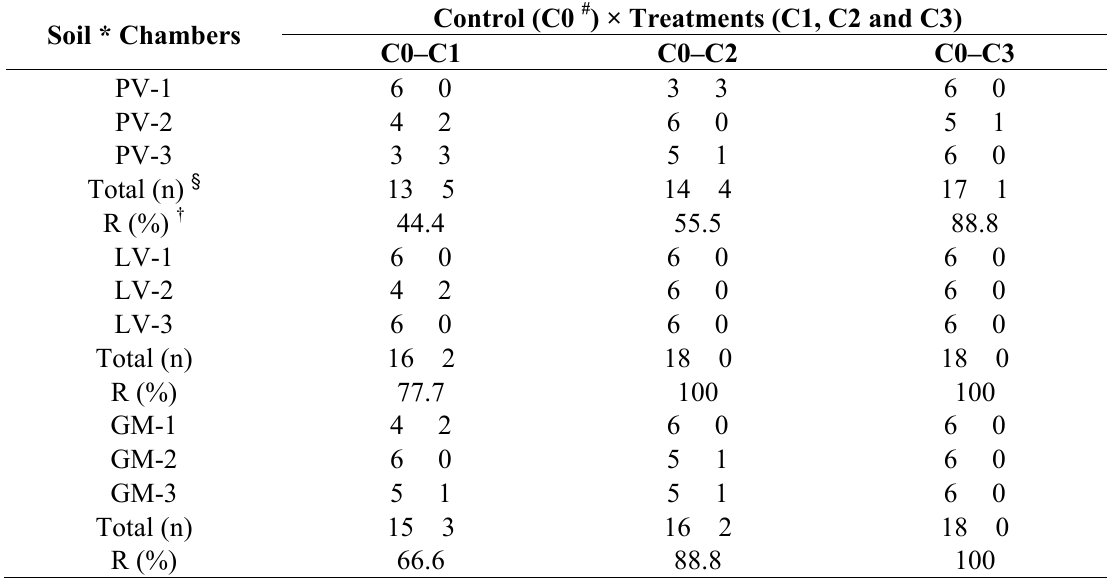
Table 3. Avoidance of the earthworms Eisenia andrei to three different agricultural soils treated with different concentrations of the wettable formulation of